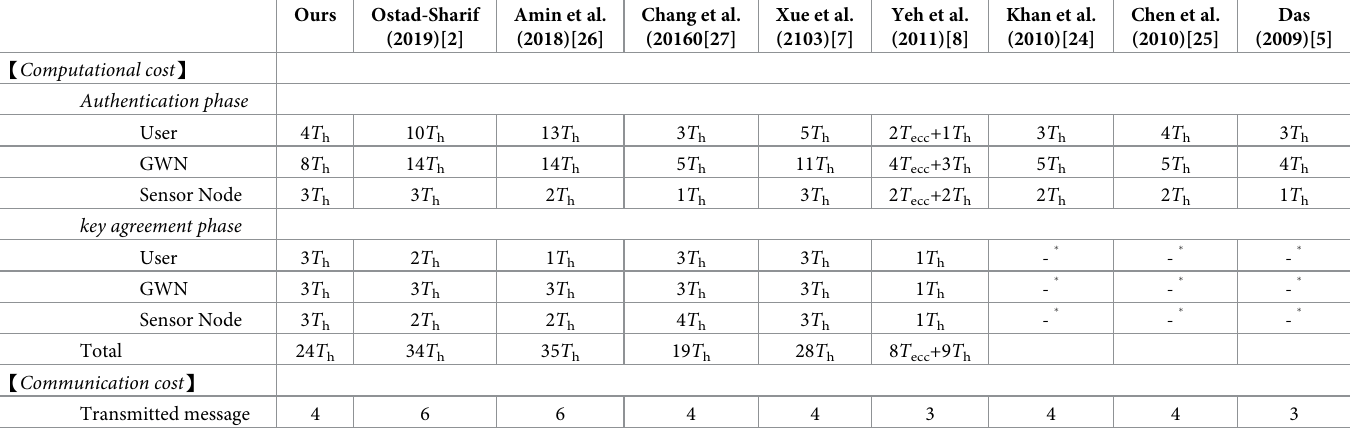
Table 4. Performance comparison of our scheme with other related